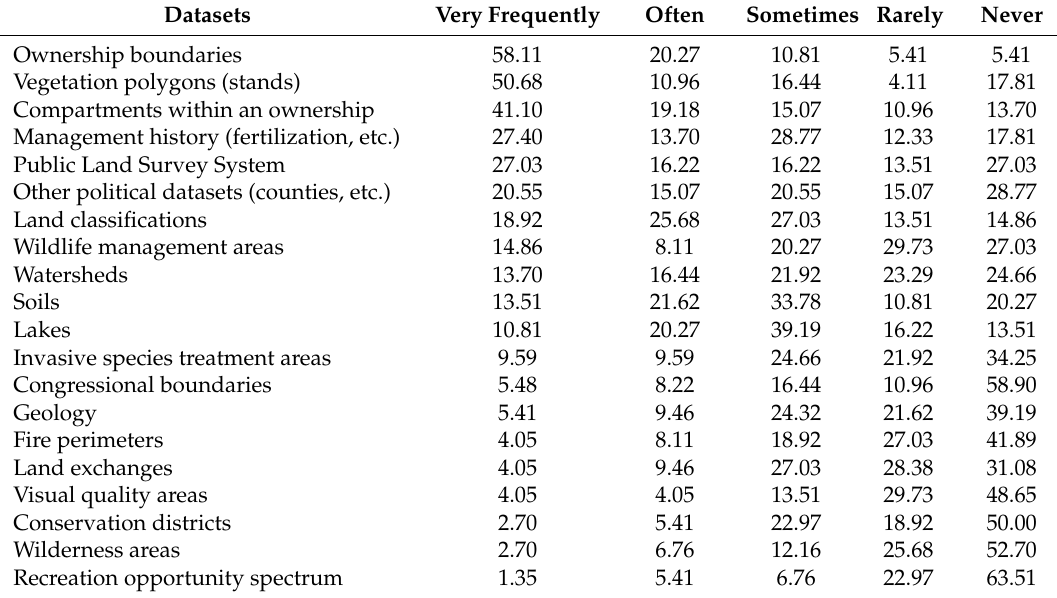
Table 5. Frequency of use (percent of respondents) of vector polygon datasets by recent graduates from forestry programs at Mississippi State University, Oregon State University, and the University of Georgia.